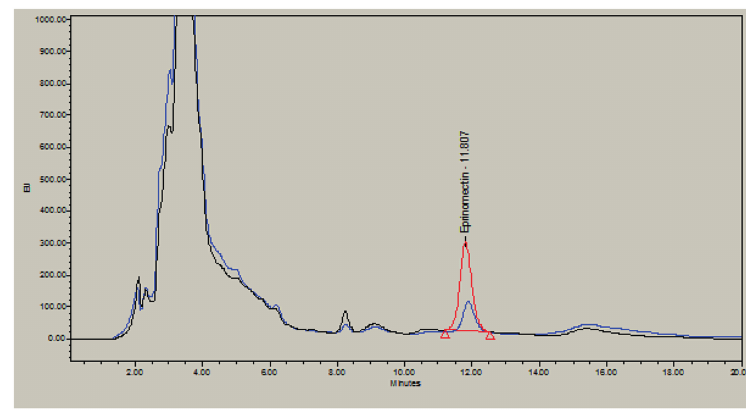
Figure 8: Chromatogram for a milk sample fortified at 2 μg kg -1 (LOQ).